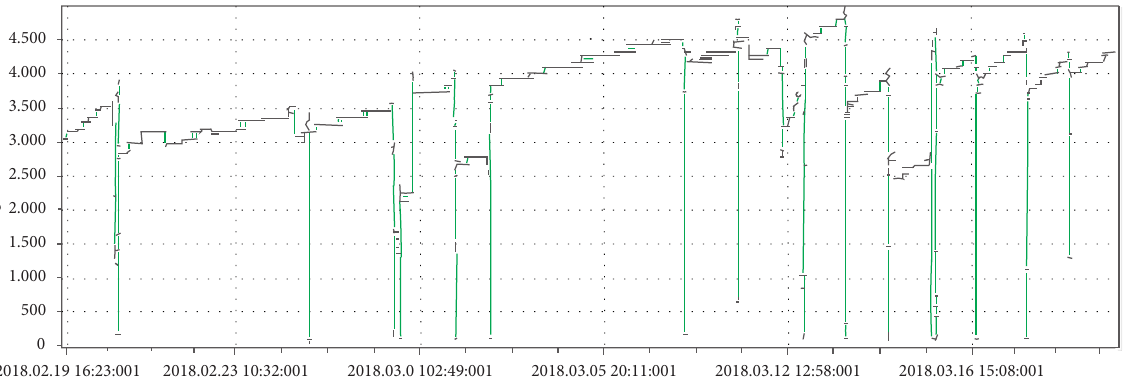
Figure 4: 1 #online monitoring of working resistance of extension Support (2018.02.19–2018.03.16).